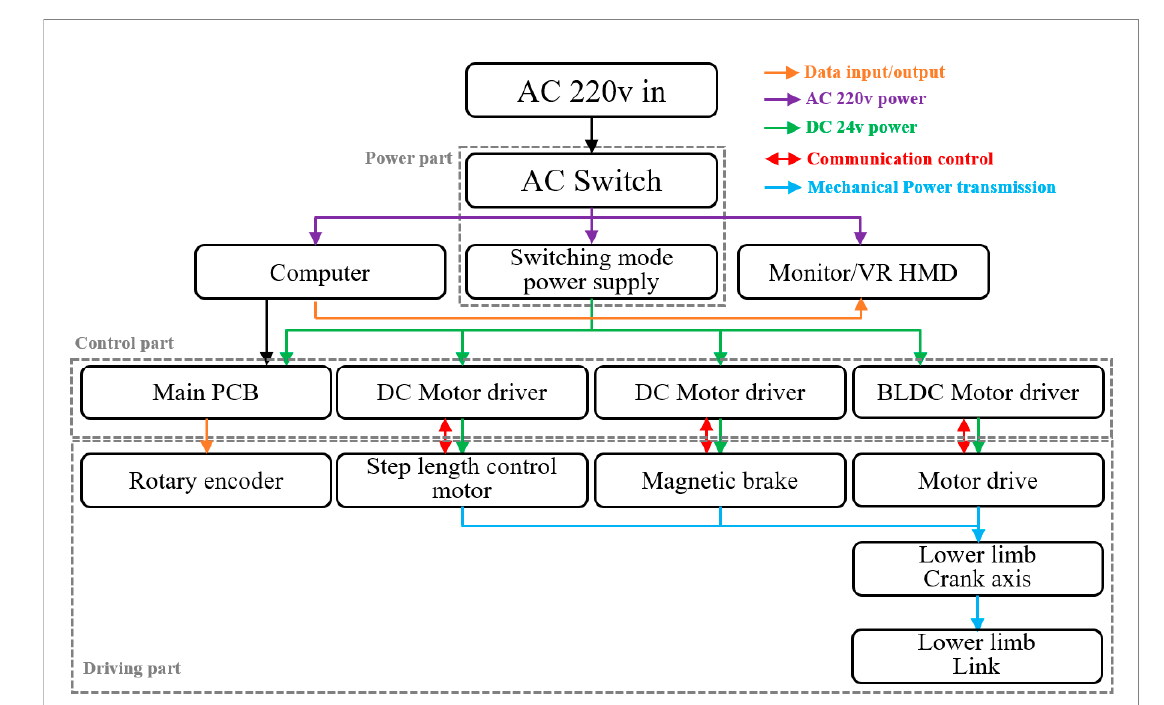
Figure 3. Block diagram of MGTR system operation.